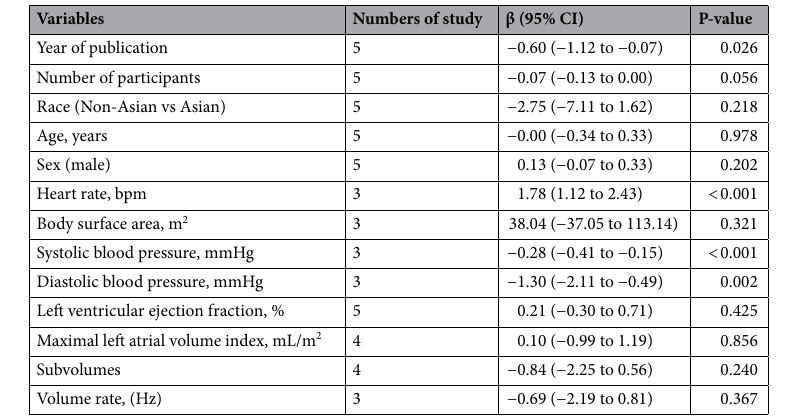
Table 2. Meta-regression analysis for longitudinal three-dimensional speckle tracking echocardiography derived left atrial strain during reservoir phase. CI confidence